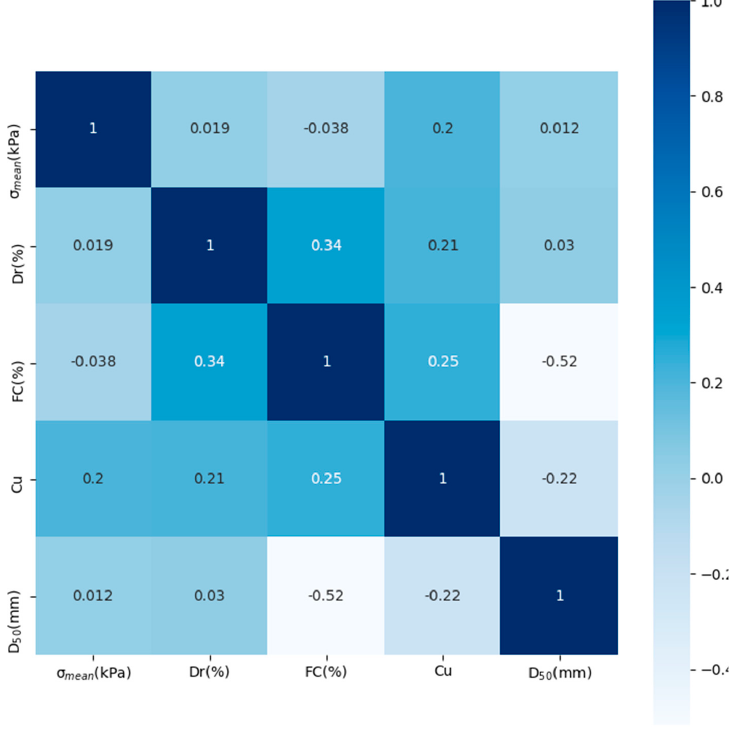
Figure 2. Spearman rank correlation coe ffi cient for input